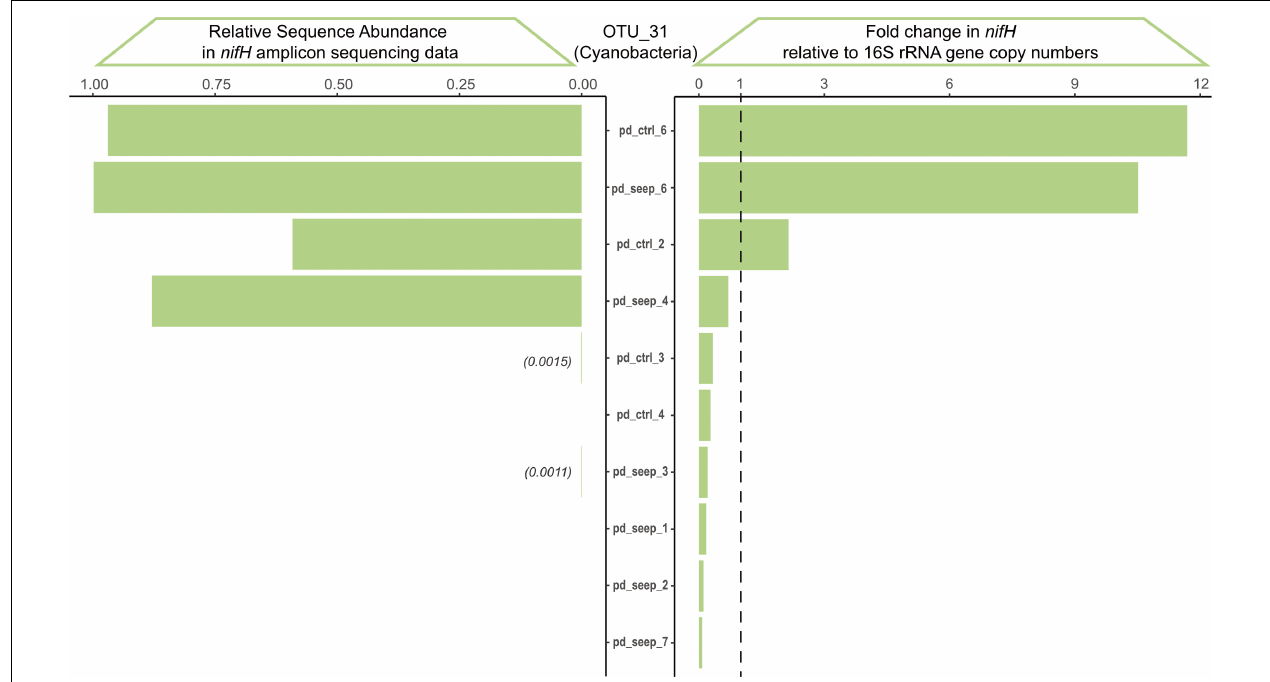
FIGURE 4 | Validation of nifH amplicon sequencing results via qPCR based on OTU_31. OTU_31 annotates as a Cyanobacterium with broad prevalence across P. damicornis samples. The qPCR fold-change in nifH gene copy numbers was calculated relative to the 16S rRNA amplicon and shows high correlation to the relative sequence abundance determined from the nifH amplicon sequencing dataset across the 11 samples of P. damicornis (Pearson correlation coefficient r = 0.87, p = 4*10 - 4 ).